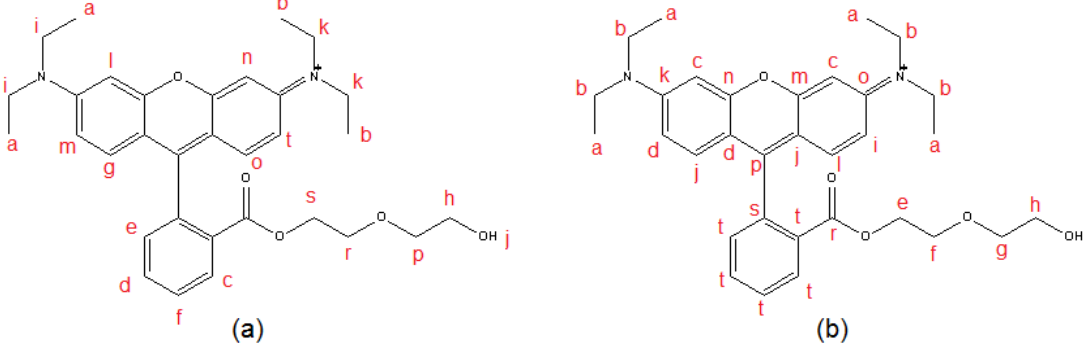
Figure 2. Chemical structure of the N -(9-(2-carboxyphenyl)-6-(diethylamino)-3 H -xanthen-3-ylidene)- N -ethylethanaminium (Rhod-OH): ( a ) 1 H-NMR; ( b ) 13 C-NMR .